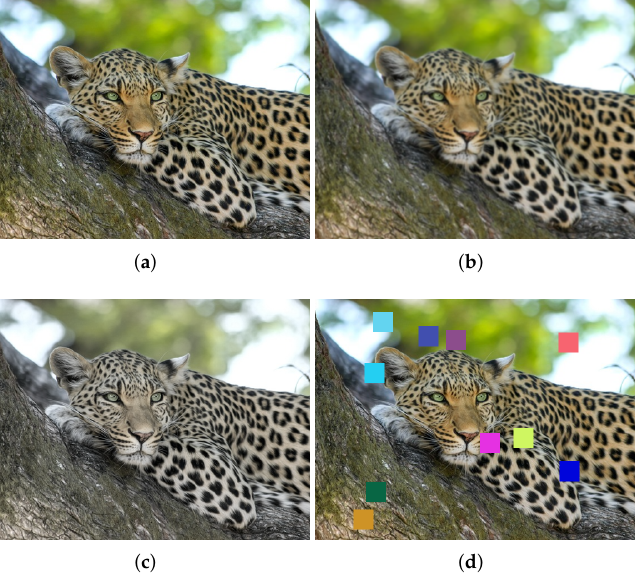
Figure 6. Sample images from KADID-10k [5]: ( a ) Reference, pristine image, ( b ) Gaussian blur, MOS = 3.20, ( c ) Color saturation, MOS = 3.13, ( d ) Color block, MOS =